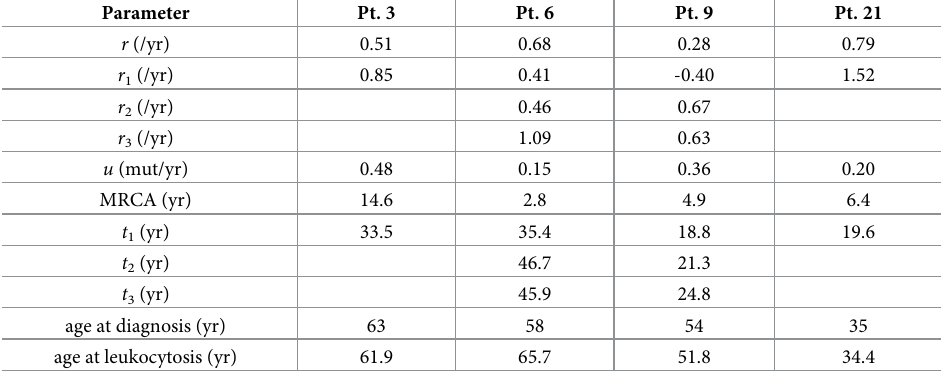
Table 1. Inferred parameters for CLL patients with exponential growth patterns, for which there are at least two longitudinal bulk sequencing measurements before treatment. Estimates are computed from tumor size measure- ments and mutation frequencies from whole exome sequencing. Mutation rates are for the exome only. The time esti- mates are in terms of the patient’s age in years.